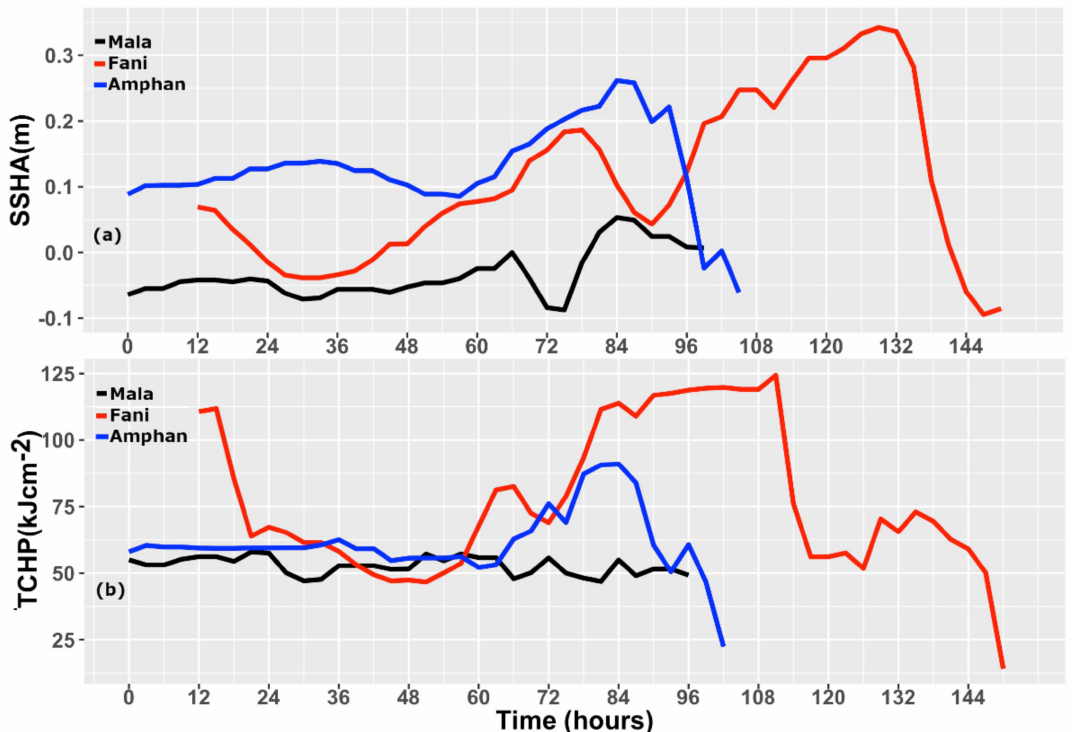
Figure 13. Along-track sea surface height anomaly (SSHA in m) ( a ) and along-track tropical cyclone heat potential (TCHP in kJ cm − 2 ) ( b ) for cyclones Mala, Fani, and Amphan formed over the BoB during the pre-monsoon season